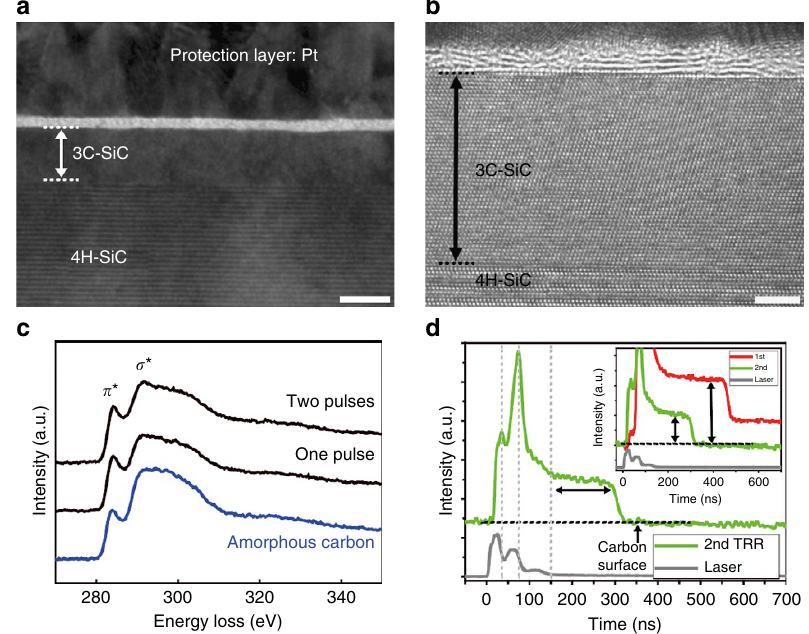
Figure 4 | Sublimation of only the poly-Si layer from the phase-separated layer. ( a ) Bright-field TEM image of 4H-SiC surface after two irradiation pulses. Scale bar, 10nm. ( b ) HRTEM image of graphitic C and 3C-SiC layers on top surface in a . Scale bar, 3nm. ( c ) EELS spectra of C layers (black lines) obtained from surfaces with one and two irradiation pulses. The blue line is the spectrum of an amorphous C layer as reference. ( d ) TRR signal of the 4H-SiC surface during the second irradiation pulse. The grey line shows the laser intensity as a function of time. Inset compares the absolute amount of reflectances produced by one irradiation pulse (the first, red line) and an additional pulse (the second, green line).